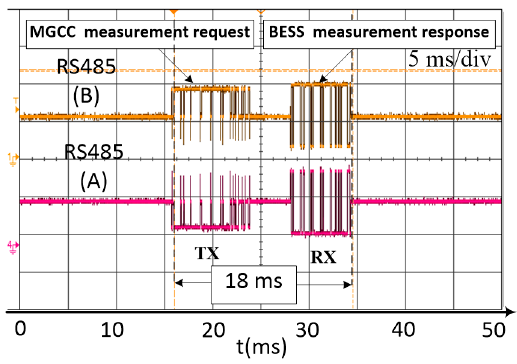
Figure 17. Experiment #4. Communication delays between the MGCC and the BESS.